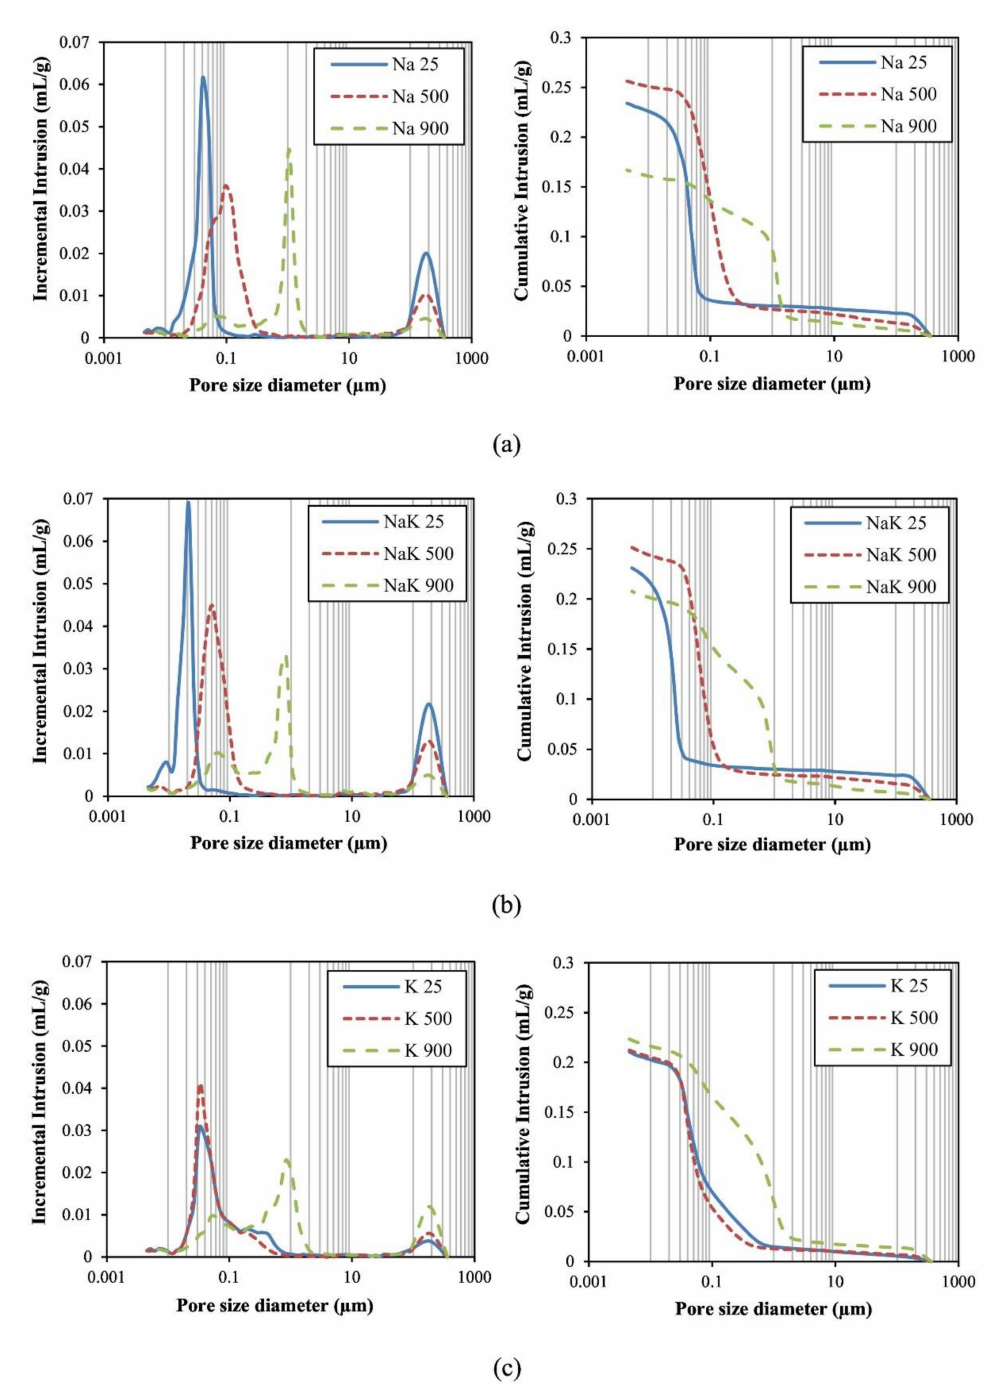
Figure 4. Pore size distribution in geopolymers before and after elevated temperature exposure ( a ) Na-, ( b ) NaK-, and ( c ) K-